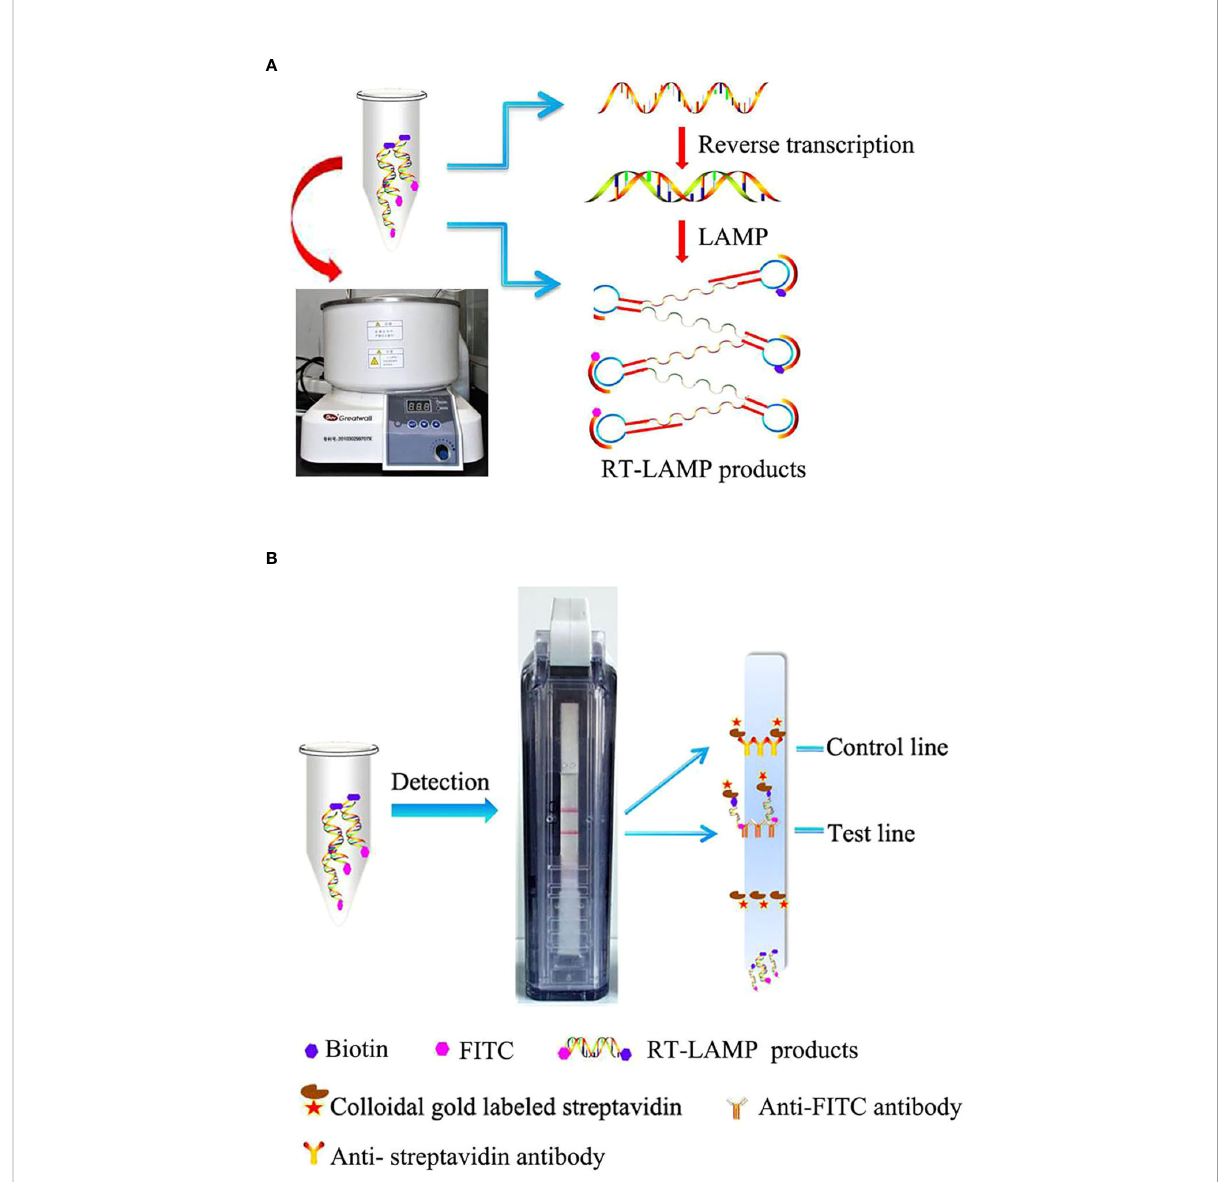
FIGURE 2 Schematic illustration of the reverse transcription loop-mediated isothermal ampli fi cation and vertical fl ow visualization (RT-LAMP-VF) assay. Figure adopted from Huang et al. (2018). (A) RT-LAMP was executed in a water bath at a constant temperature. (B) The products of RT-LAMP were detected by using a vertical fl ow visualization